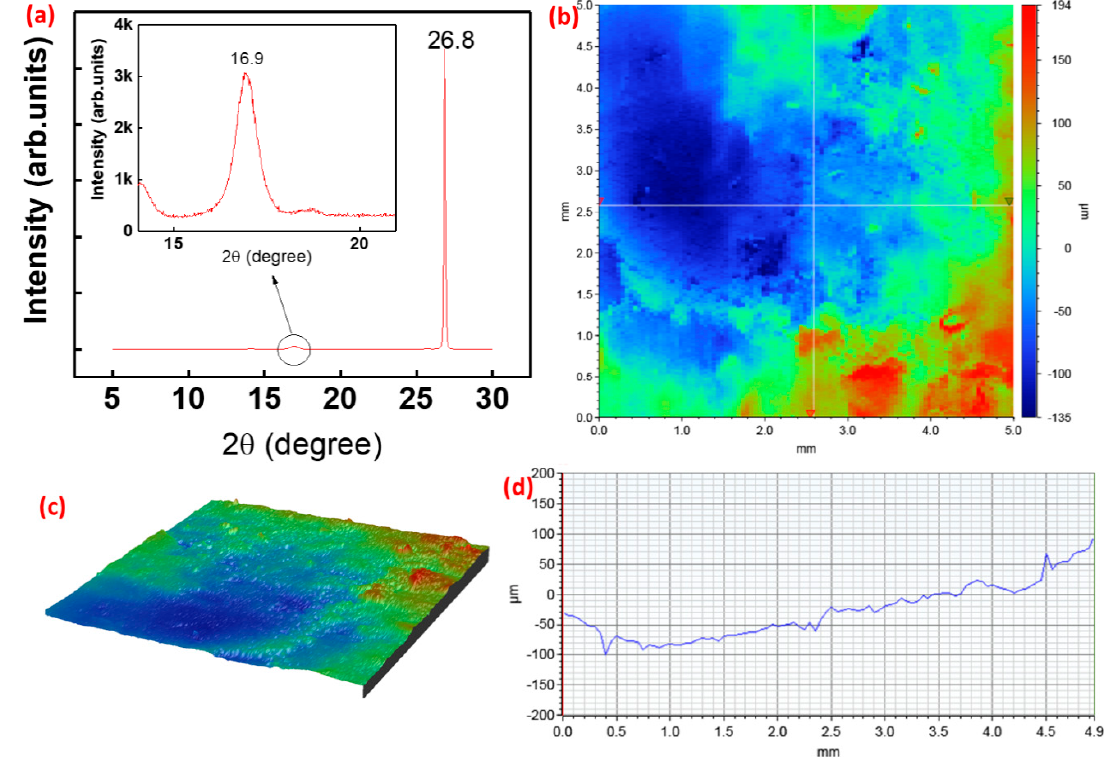
Figure 3. ( a ) X-ray diffraction (XRD) spectrum of the film ( b ) surface profile scanning of the graphite-polyurethane (G-PU) composite film over an area of 5 × 5 mm 2 ( c ) 3D surface image of the sensitive electrode for roughness measurement. ( d ) Morphological scan on surface roughness.